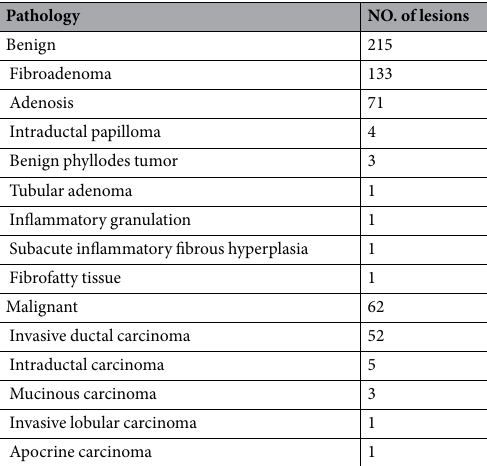
Table 1. Final histologic features of breast